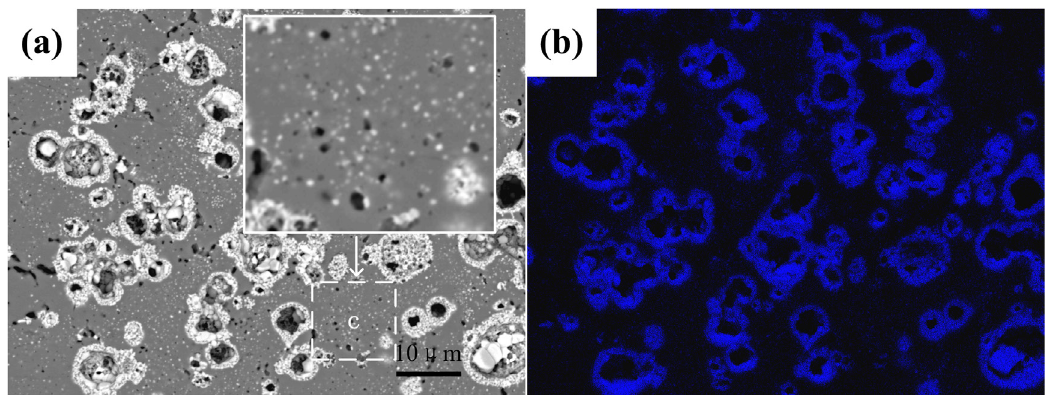
Figure 9. ( a ) SEM morphology and ( b ) EDS elemental map of Zn element distribution map of ZnO/HA composite sample with 20% Zn addition sintered at 1250 °C for 2 h.